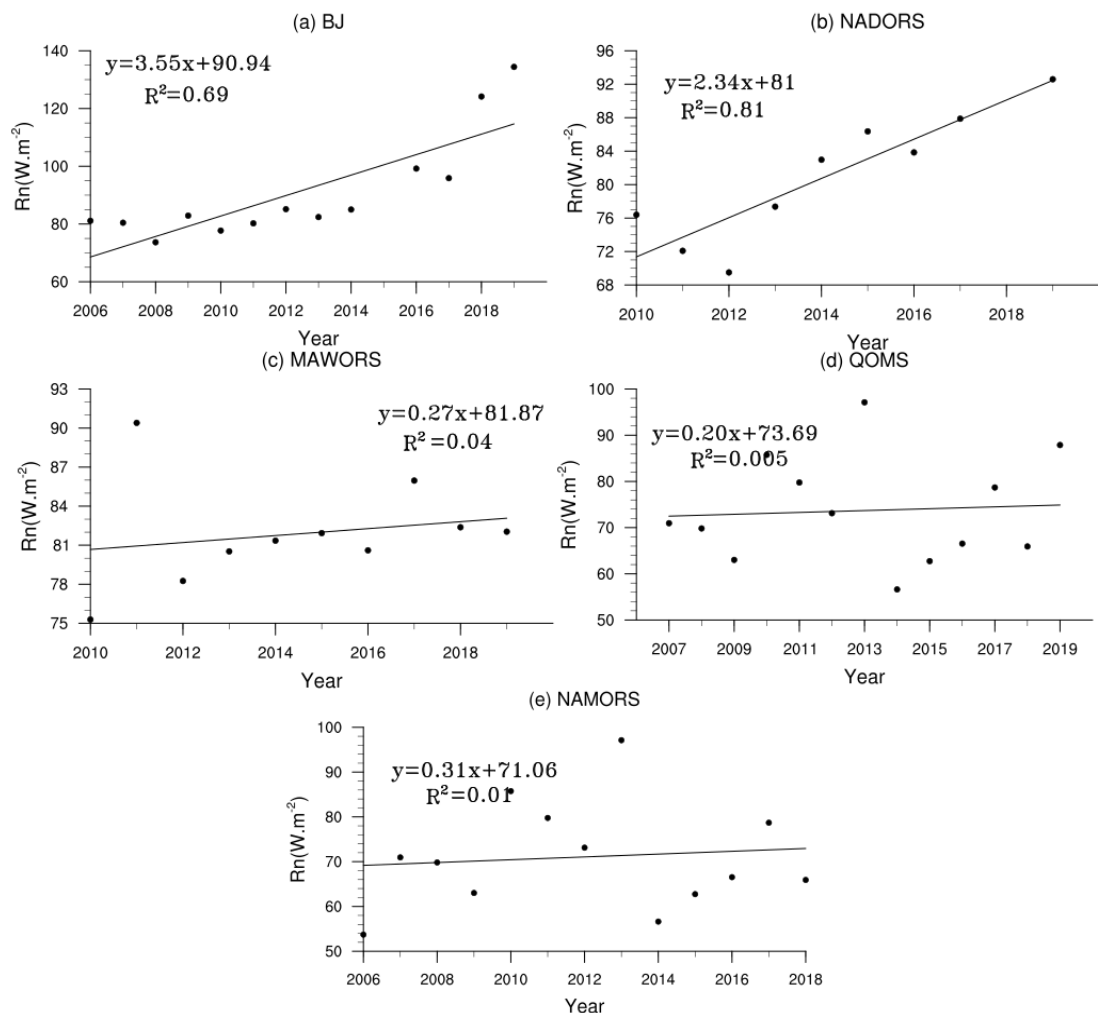
Figure 20. Interannual variation of net radiation of each station.